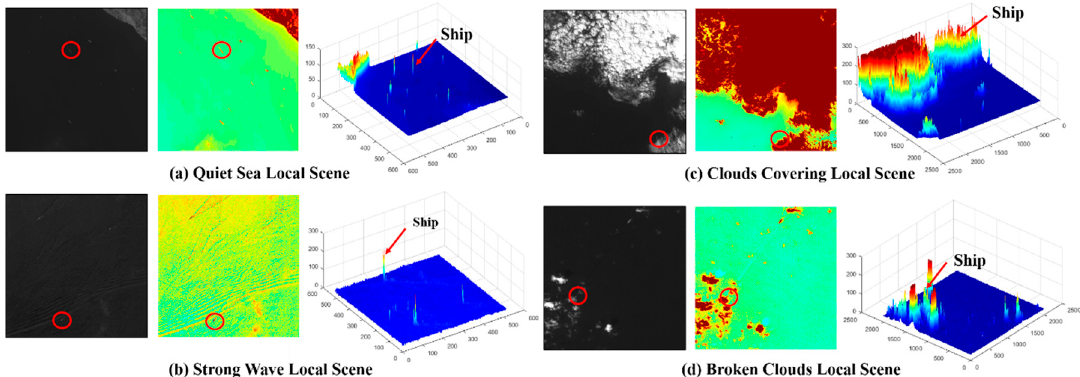
Figure 1. Examples of ocean ship detection in full scenes of ocean optical remote sensing images. ( a ) is a local scene with a quiet sea; ( b ) is a local scene with strong wave; ( c ) is a local scene with cloud cover; and ( d ) is a local scene with broken clouds.